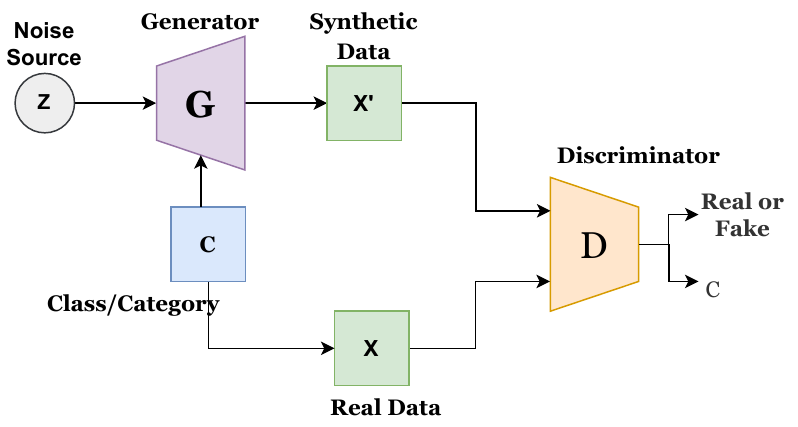
Figure 2. Architecture of existing InfoGAN